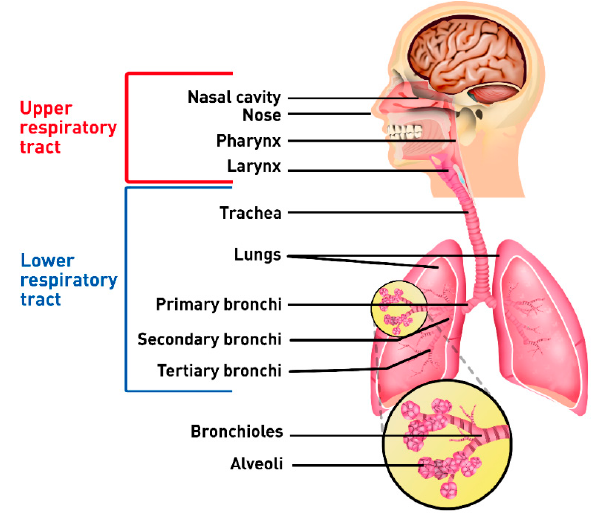
Figure 1. Anatomical representation of the human respiratory system.